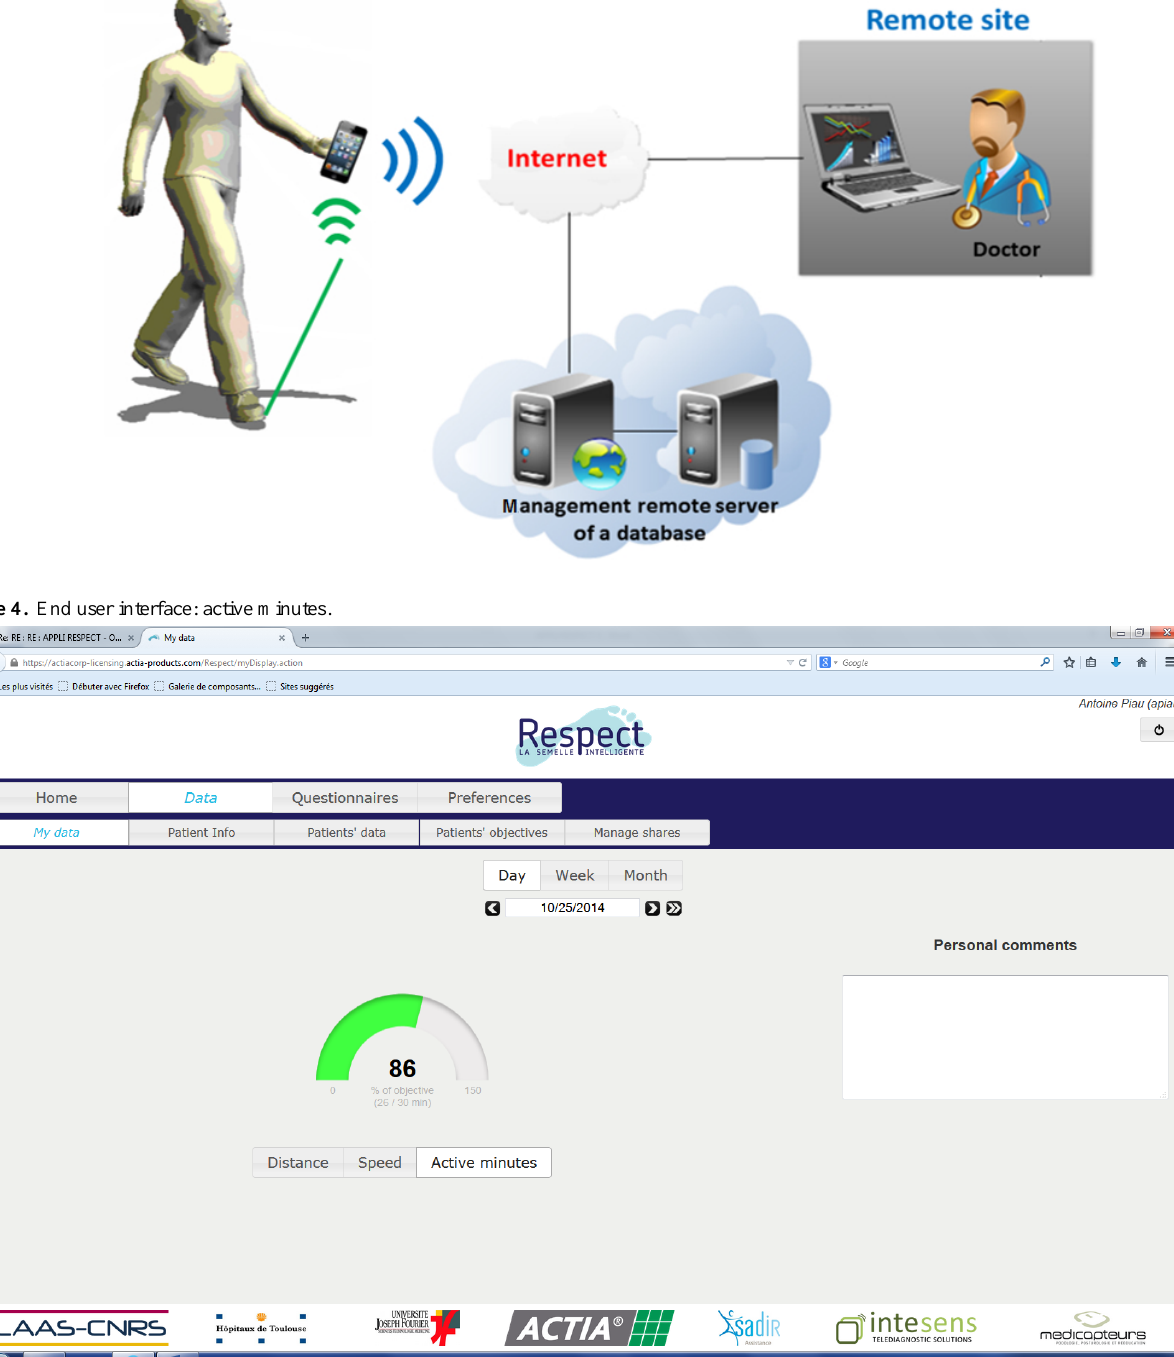
Figure 3. Operational setup.